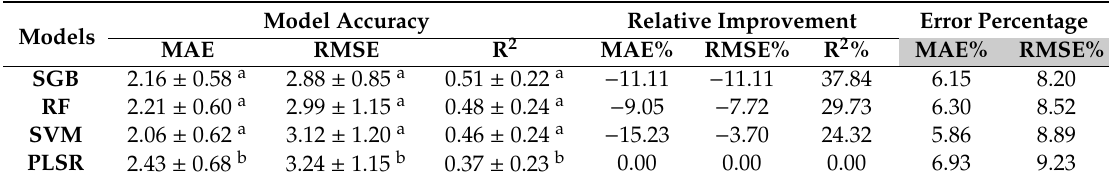
Table 3. Comparison of model fitting parameters among four modeling methods. Relative improvement of model accuracy, precision and fitness was calculated against partial against partial least squared regression.